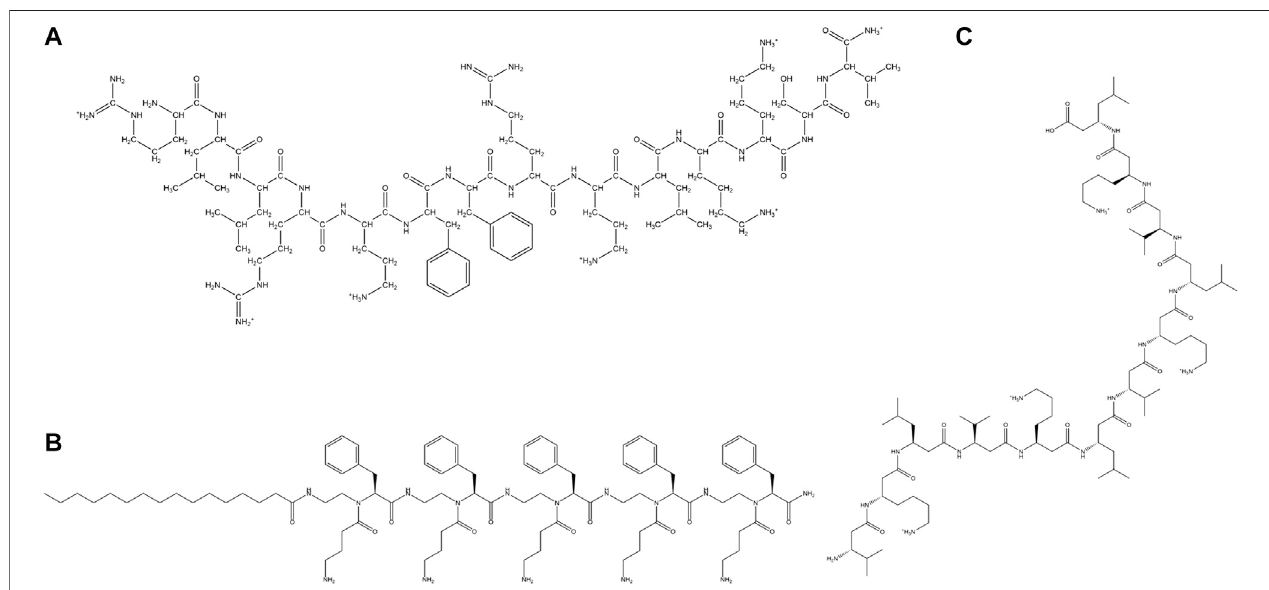
FIGURE 7 | Examples of synthetic cationic AMPs containing unnatural amino acid residues. (A) Cbf-14 – 2 (Kang et al., 2017). (B) NB-119 – 2 (Hu et al., 2012). (C) β -amino acid containing peptide H-( β 3 -H-Val- β 3 -H-Lys- β 3 -H-Leu) 4 -OH (Liu and De Grado, 2001).